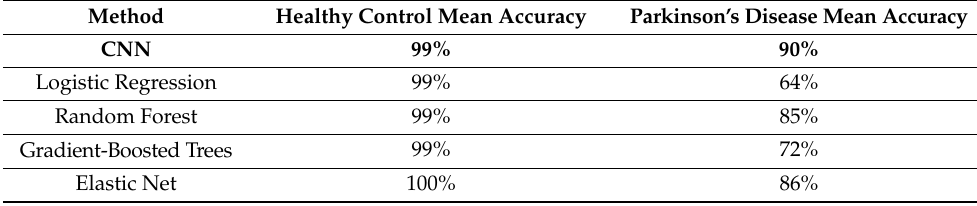
Figure 5. Daily average PD classification results: ( a ) average daily LOGO CV accuracy for first 10 days of sensor data; ( b ) average 5-day accuracy for data after 1, 2, and 3 months.